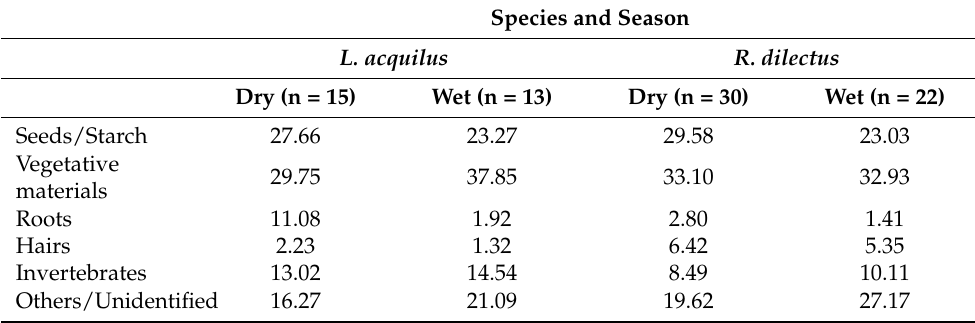
Table 4. Relative importance in percentage (%) and sample size (n) of Lophuromys acquilus and Rhabdomys dilectus in moorland habitat across the 2